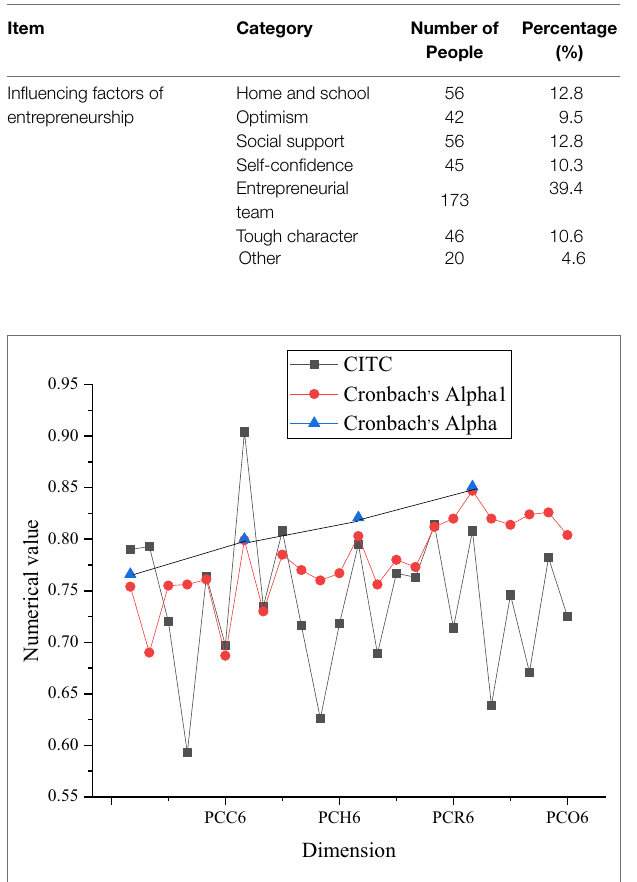
FIGURE 3 | Reliability analysis of psychological capital (PCC6 represents six evaluation factors of psychological capital confidence dimension, PCH6 represents six evaluation factors of hope dimension, PCR6 represents six evaluation factors of tenacity dimension, and PCO6 represents six evaluation factors of optimism dimension).